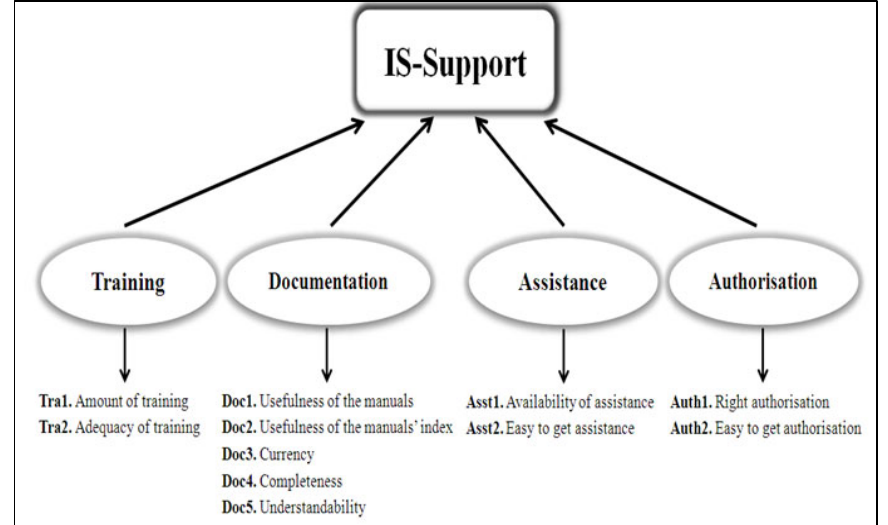
Fig. 5. The validated IS-Support